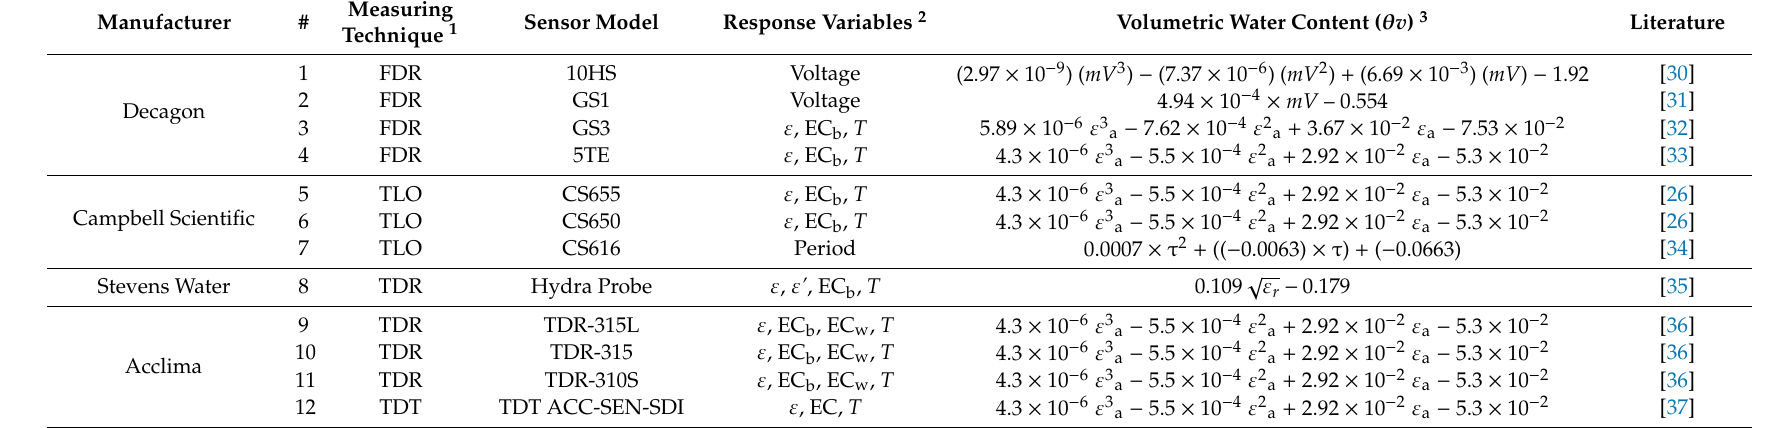
Table 1. Information on the capacitance sensors tested in this